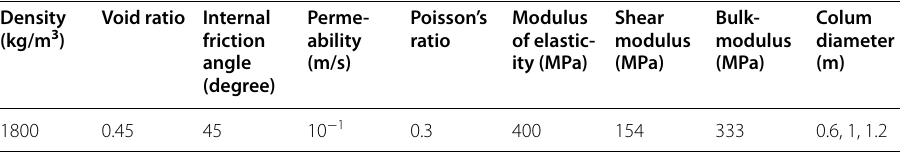
Table 2 Characteristics of stone column [26] Density (kg/m 3